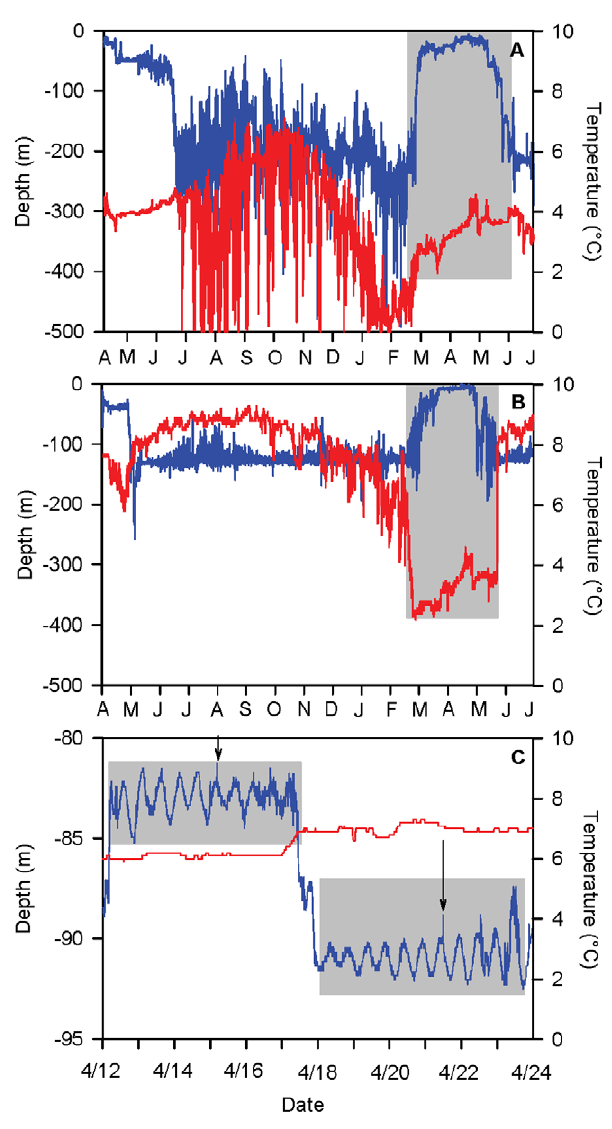
Figure 1. Temperature and depth profiles collected by electronic data storage tags implanted in Atlantic cod. Examples of one year depth and temperature profiles of frontal (A) and coastal (B) behavioral types of Atlantic cod in Iceland showing in-migration to spawning habitat, time spent at spawning grounds, and out-migration back to feeding grounds in the highlighted areas. Temperature is represented by a red line while depth is represented by a blue one. Periods interpreted as time spent in spawning aggregations was characterized by the highlighted portions with a clear tidal signature between in-migration and out-migration (C). Arrows indicate events interpreted as possible Atlantic cod spawning events as described by Brawn (1961a, b), Rose (1993), and Hutchings et al.